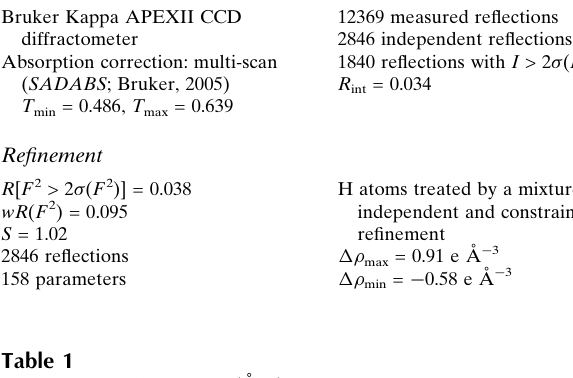
Hydrogen-bond geometry (A˚ , (cid:2) ).